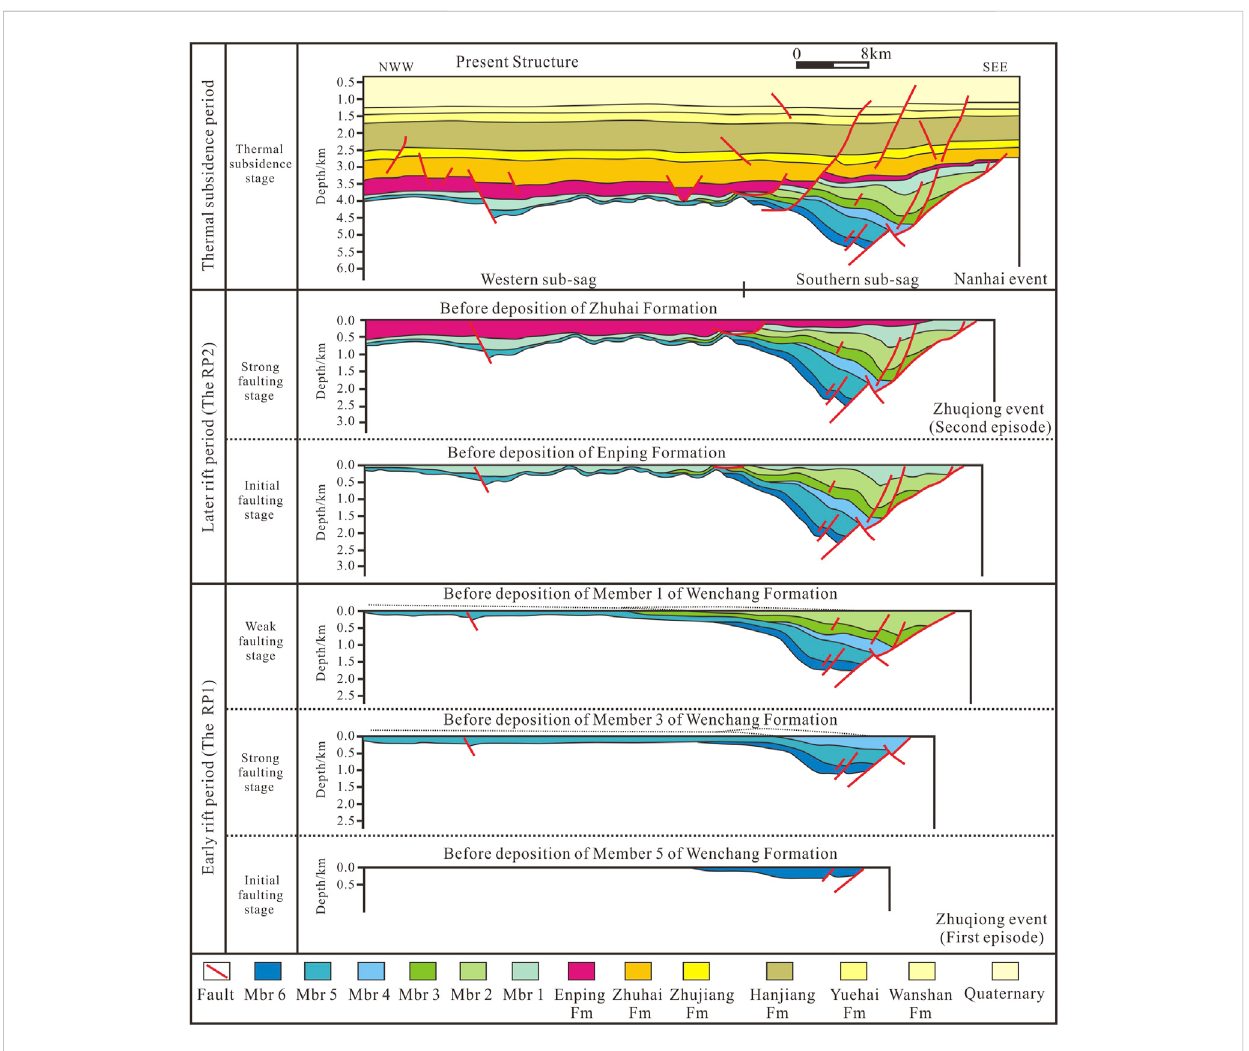
FIGURE 9 Structural evolution pro fi le of Panyu 4 Sag. Mbr - Member, Fm -